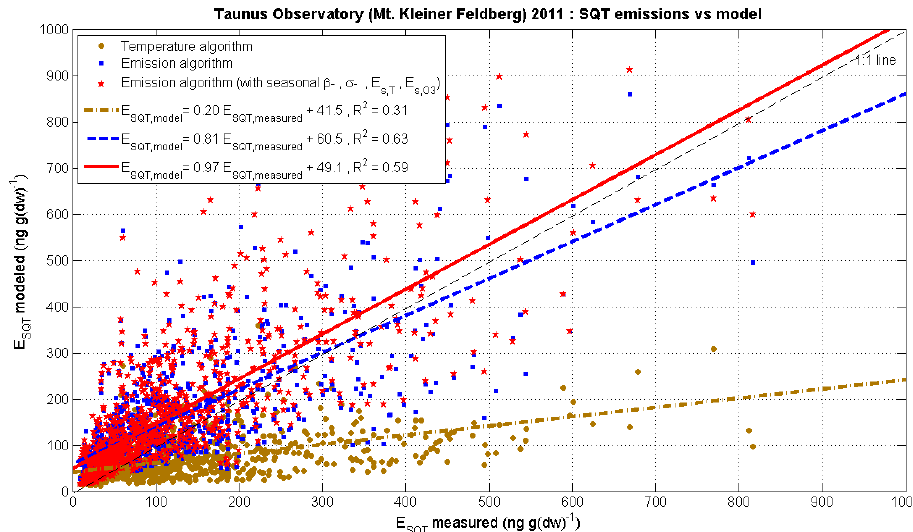
Fig. 7. Comparison between measured and calculated SQT emissions. An only temperature dependent algorithm substantially underestimates the measured emissions (gold dashed line). The addition of the ozone depended term (blue dashed line) is improving the fitting between measured and modelled emissions, while the best fit (red line) is observed when the seasonal β and σ -factors and emission potentials ( E s ,T , E s,O ) are considered in the algorithm. 3